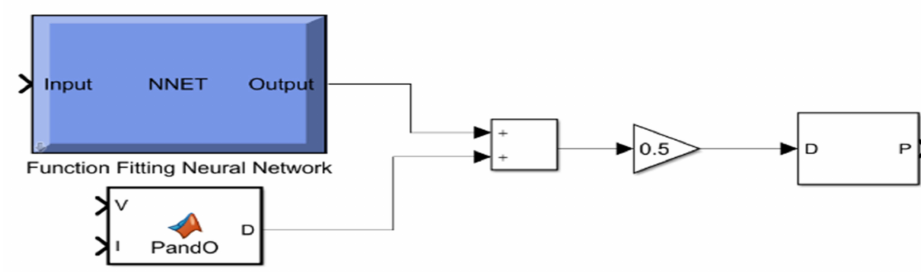
Figure 37. Block diagram of the hybrid model [21–23].